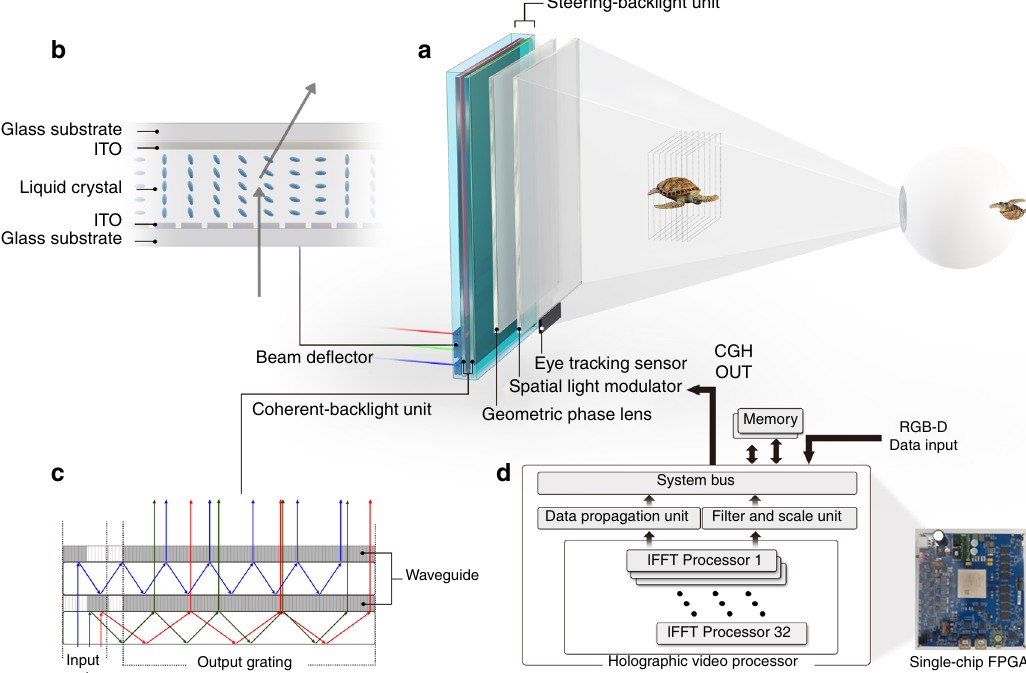
Fig. 3 Schematics of the optical architecture with key components and the holographic video processor. a Optical architecture consists of beam de fl ectors, coherent-backlight units, a geometric phase lens and a spatial light modulator. b Principle of the beam de fl ector, which steers the transmitted lights optically like a prism: the vertical and horizontal phase arrays steer light up to ~15° with the angular resolution of 0.02° at the wavelength of 520 nm. c Con fi guration of the coherent-backlight unit using waveguide: the fi rst waveguide for both red and green light and the second waveguide for blue light are stacked together to increase the overall ef fi ciency. d The holographic video processor is implemented on a single-chip